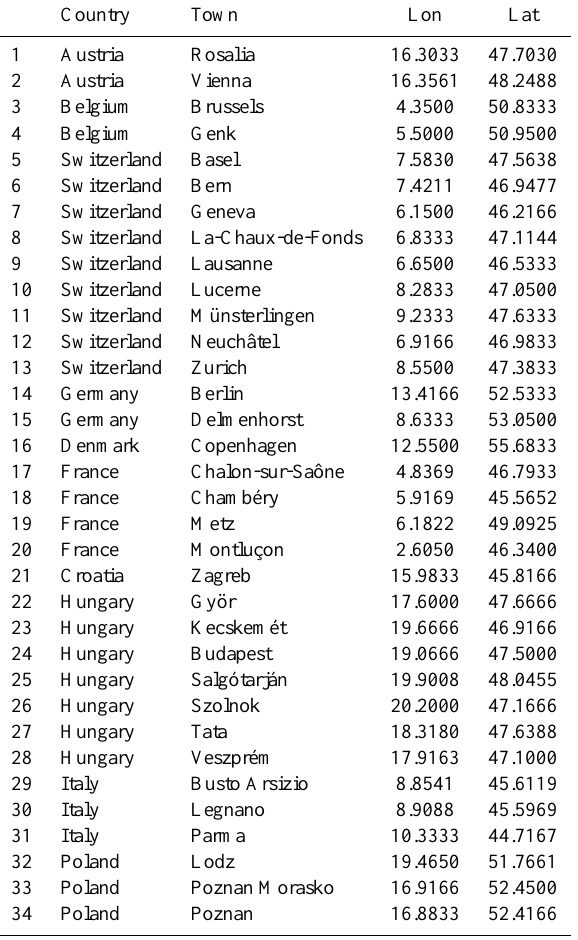
Table 2. Pollen classes for birch pollen concentrations ( C pollen ) used for the operational pollen forecasts at MeteoSwiss (Gehrig